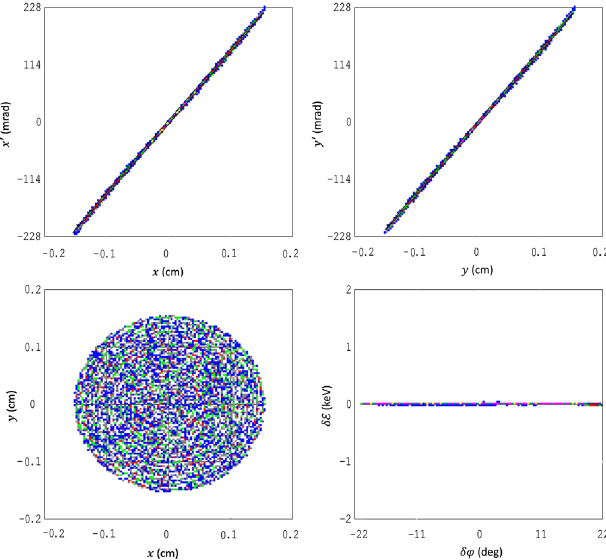
mrad.FIG. 20. Beam phase-space in the plane of the electric wall of the input aperture. The cathode is flat ; the emittance is 0.423 mm mrad.